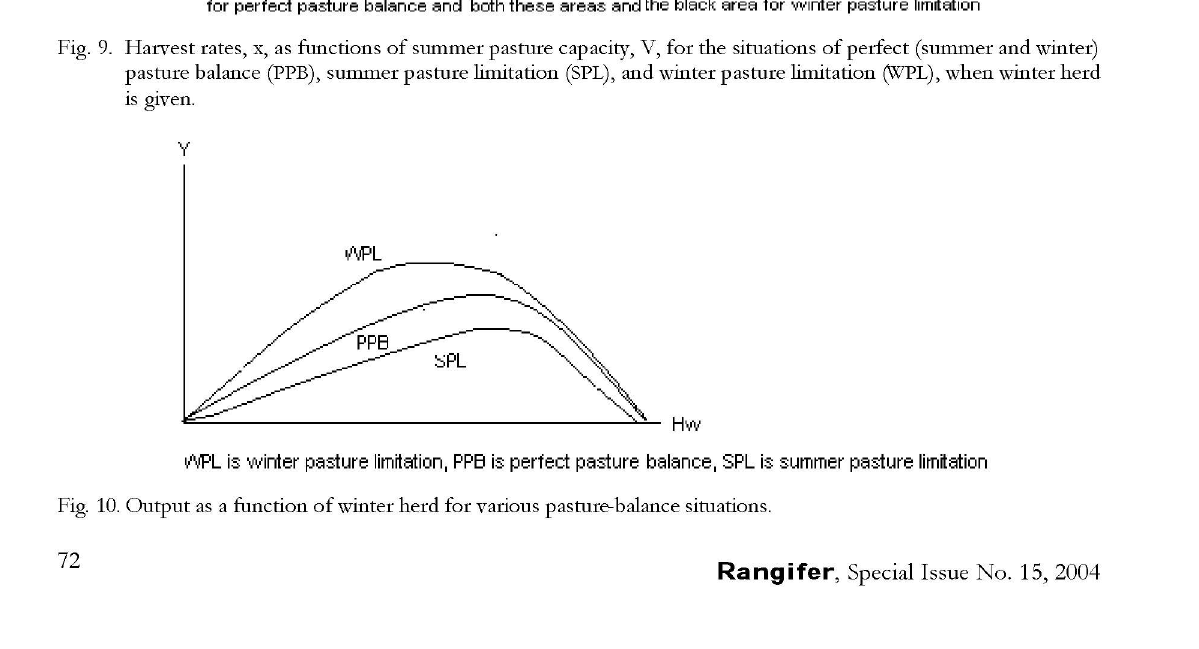
Fig. 9. Harvest rates, x, as functions of summer pasture capacity, V, for the situations of perfect (summer and winter) pasture balance (PPB), summer pasture limitation (SPL), and winter pasture limitation (WPL), when winter herd is given.